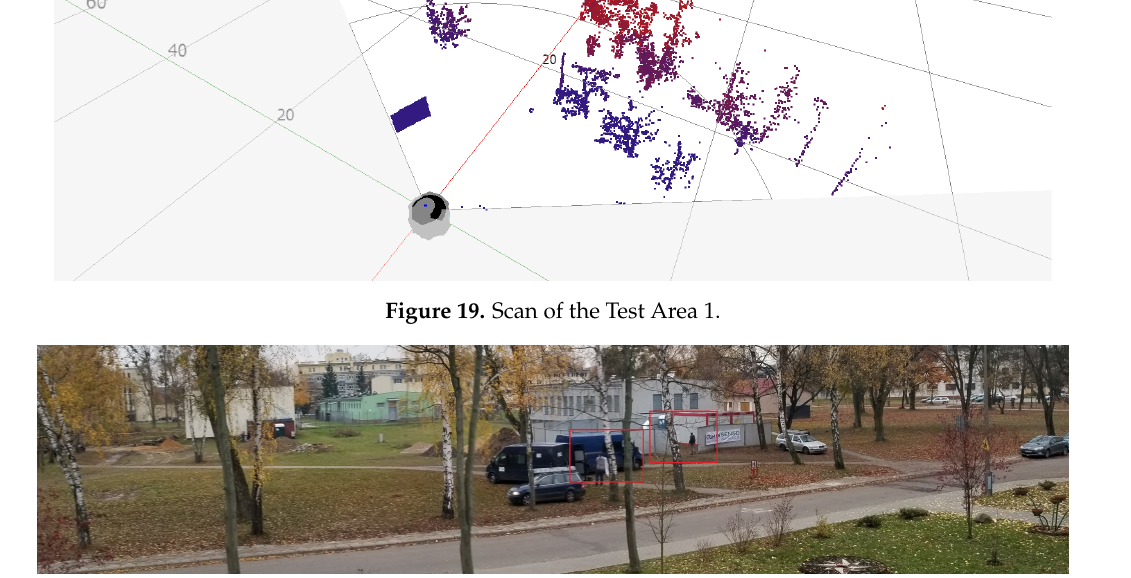
Figure 20. Panoramic picture of the Test Area 2.